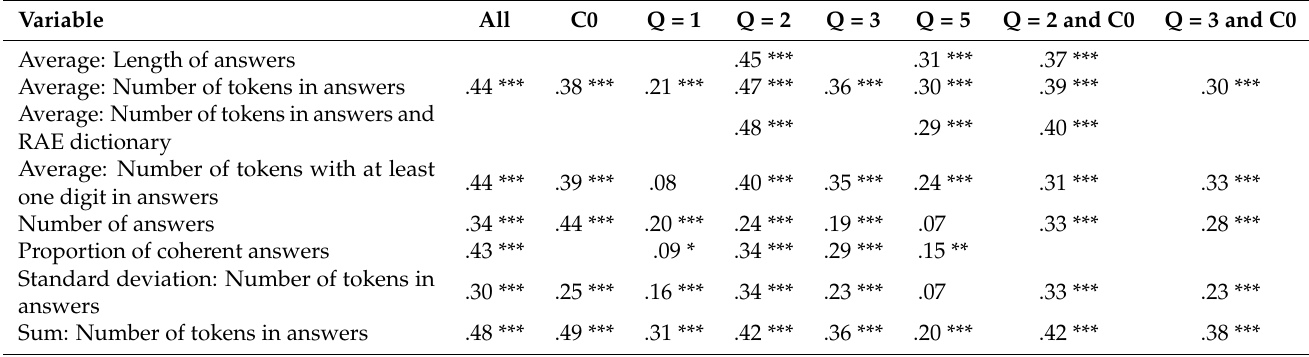
Table 1. Some interesting regressors using simple indicators and Traditional/Semantic/Context features of the answer. Correlation corresponds to the Pearson coefficient between the regressor and SIMCE score. The notation C0 corresponds to filter by coherent responses. The notation Q corresponds to filter by responses to Q-type questions.